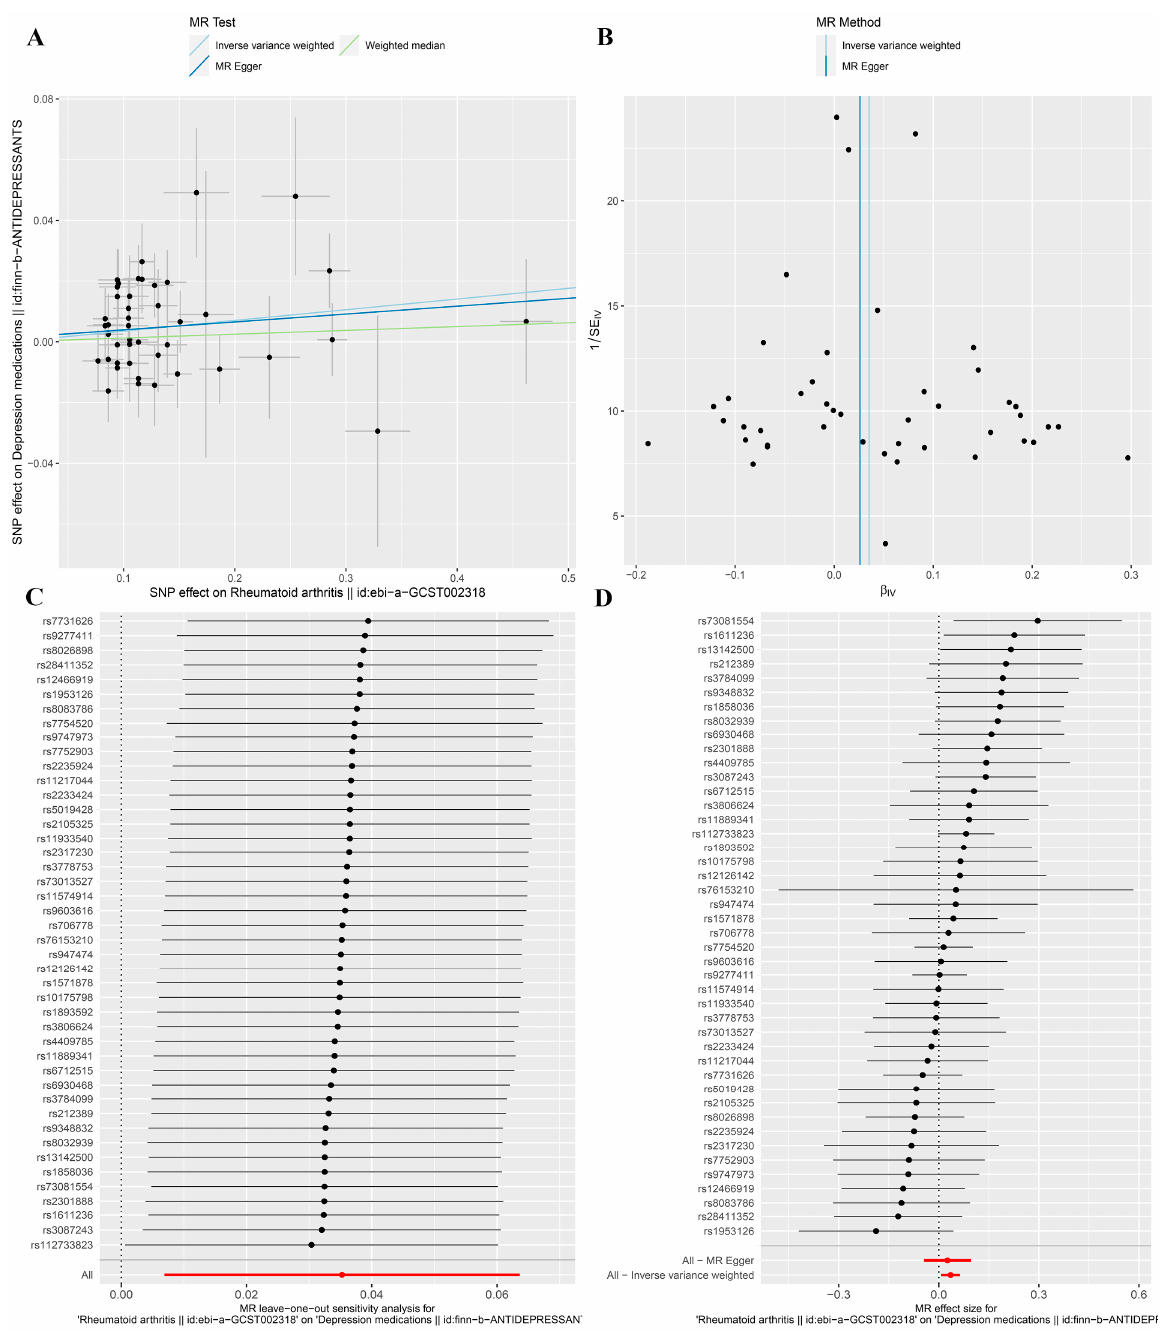
Figure 4. Association between genetically predicted rheumatoid arthritis (after removing outliers) and depression medications presented in ( A ) scatter plot, ( B ) funnel plot, ( C ) leave-one-out sensitivity analysis, and ( D ) forest plot.